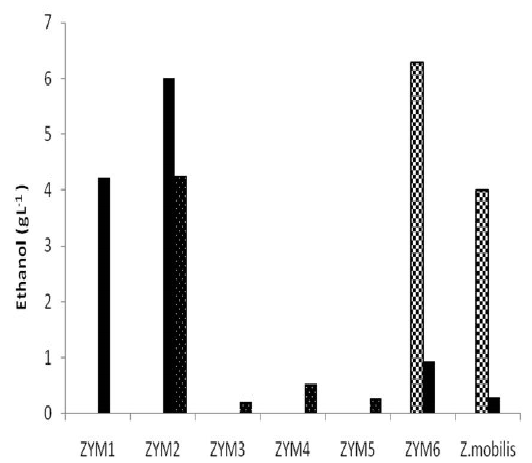
Fig 2. Effect of pH on ethanol production by isolated bacteria. ( ) pH 2, ( ) pH 4, ( ) pH 6 and ( ) pH 8.